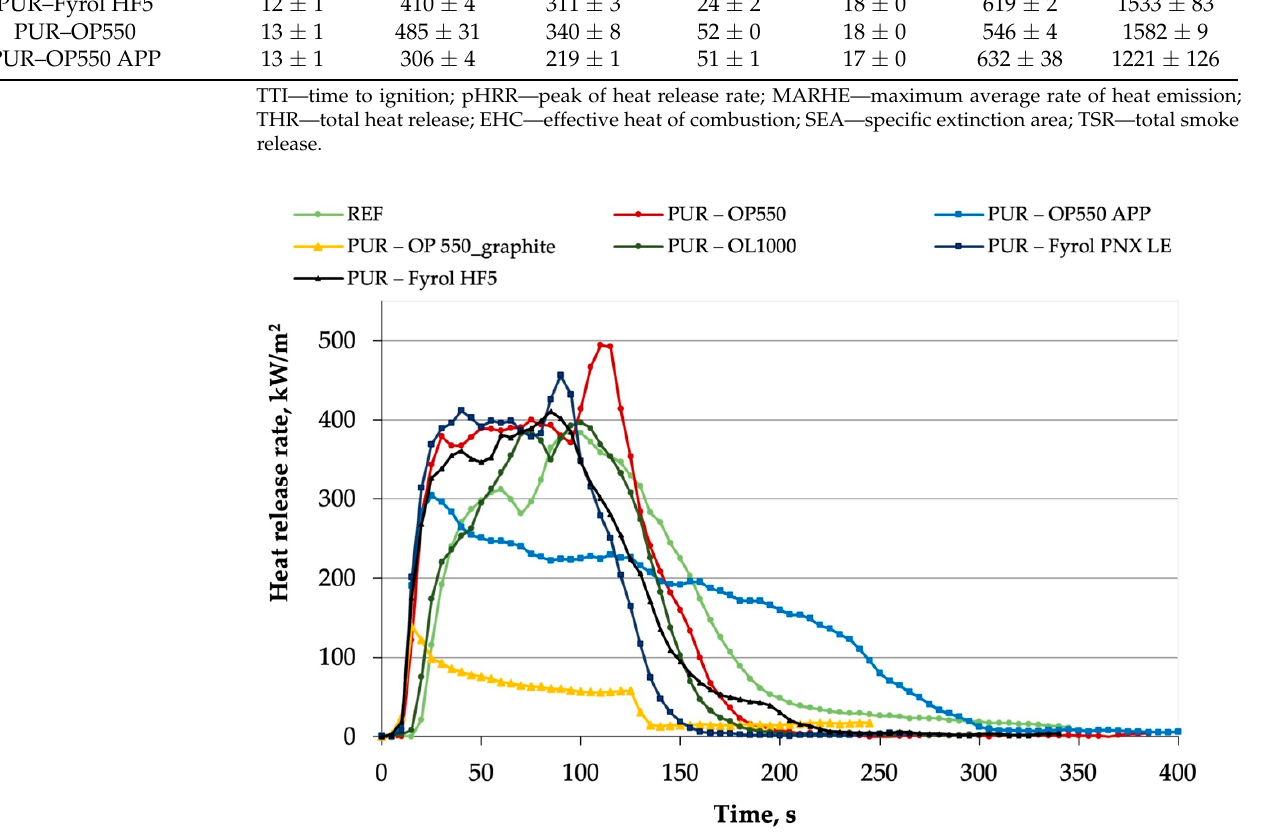
Figure 10. Representative curves of heat release rate obtained for foams modified with flame retardants. Table 9. Foams burning parameters depending on the flame retardant.